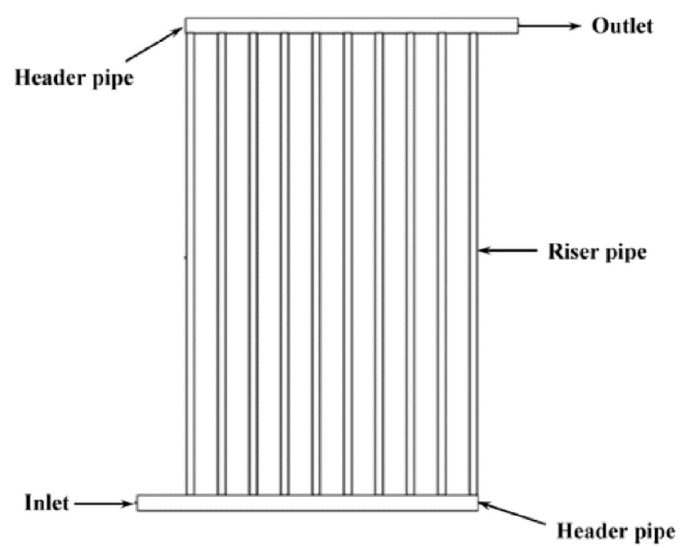
Figure 2. Schematic diagram of the FPC. Adopt from [37].